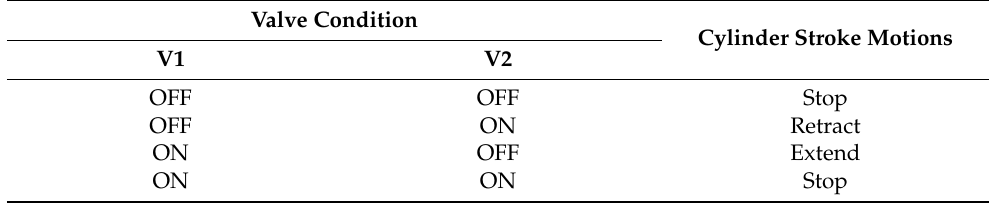
Table 1. Cylinder stroke movements.